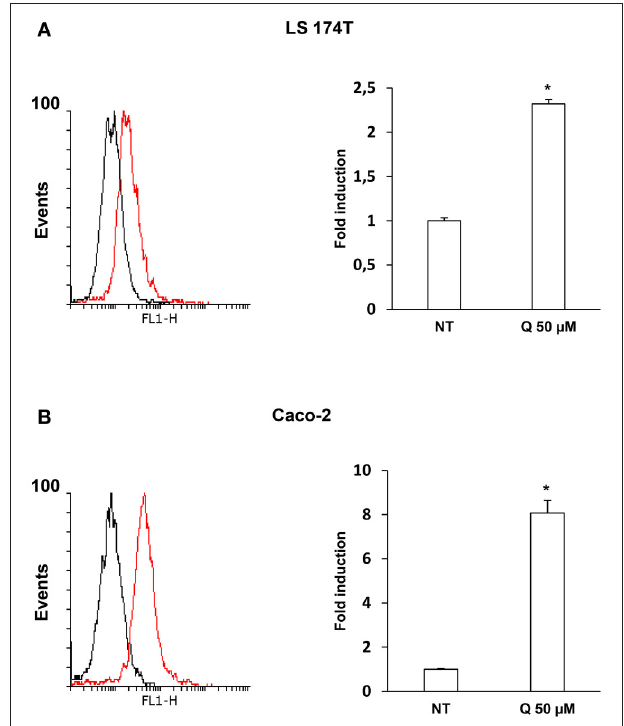
FIGURE 3 | Quercetin permeates LS 174T (A) and Caco-2 (B) cells membrane . Flow cytometric analysis using fluorescent probe DPBA for the staining of flavonoids, 10,000 cells were counted for each sample. The graph shows the mean ± SE ( n = 3) values of three independent experiments. The insert shows the histograms of a representative experiment; the red histogram denotes the sample treated with 50 µ M of Quercetin. * p < 0.001 vs.